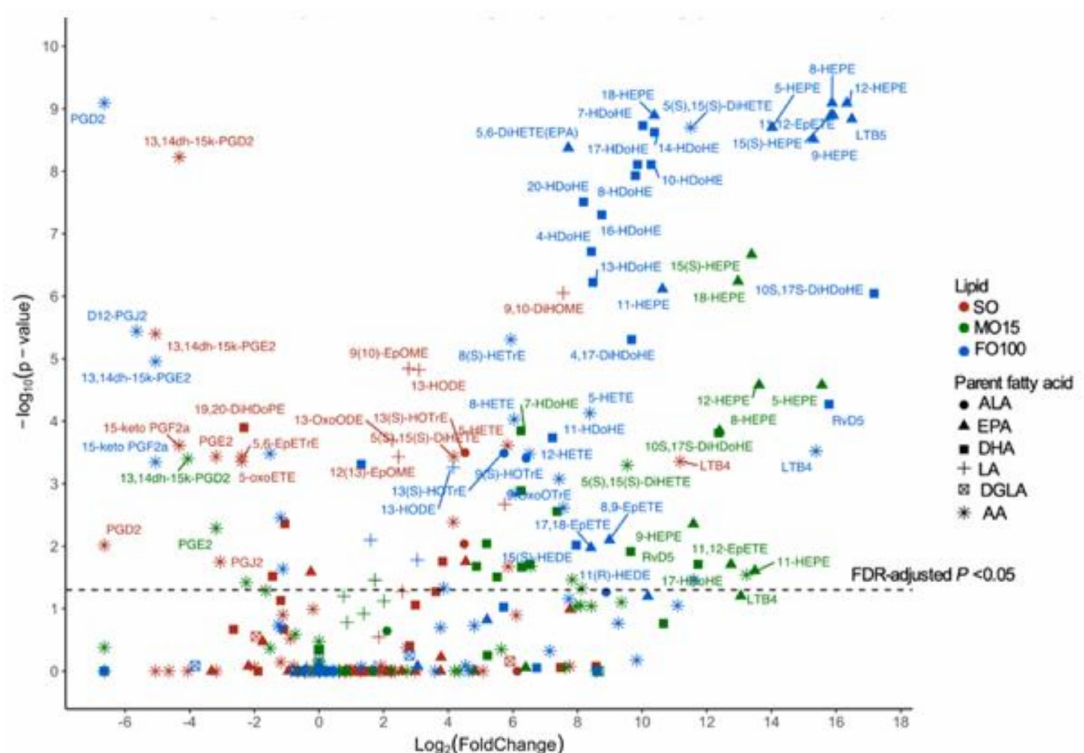
Figure 6. Changes in plasma oxylipins at day 11 compared to day zero (priming stage) by lipid group, SO ( n = 10), MO15 ( n = 9), and FO100 ( n = 10). Scatter plot shows the median fold change of oxylipins within each lipid group indicated by colors and parent fatty acids of the oxylipins indicated by shapes. AA, arachidonic acid; ALA, α -linolenic acid; DGLA, dihomo- γ linolenic acid; DHA, docosahexaenoic acid; EPA, eicosapentaenoic acid; FO100, 100 percent fish oil; LA, linoleic acid; MO15, mixed oil with 15% fish oil; SO, 100% soybean